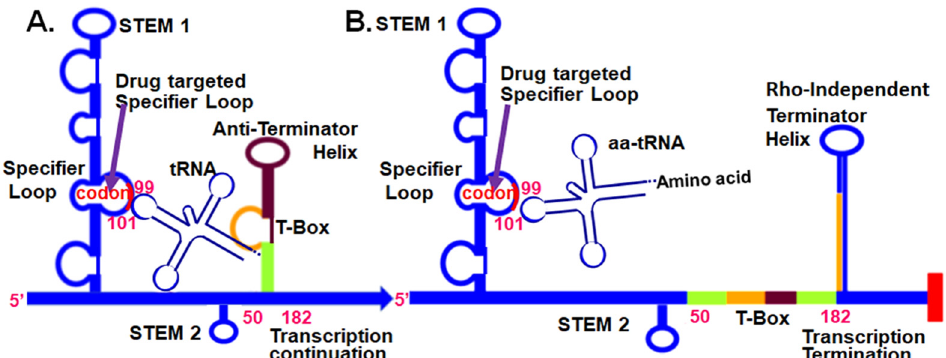
Figure 1. tRNA-dependent, T-Box, regulatory mechanism at the 5’UTR of aminoacyl-tRNA synthetase mRNAs in Gram-positive bacteria. ( A ) Unacylated tRNA bound to the T-box 5 (cid:48) UTR through the anticodon and the 3 (cid:48) -terminal CCA sequence. ( B ) The aminoacylated tRNA does not bind stably to the 5 (cid:48) UTR. Small-molecule intervention (arrow) that inhibits Specifier Loop codon interaction with an unacylated (or acylated) tRNA’s anticodon will terminate transcription